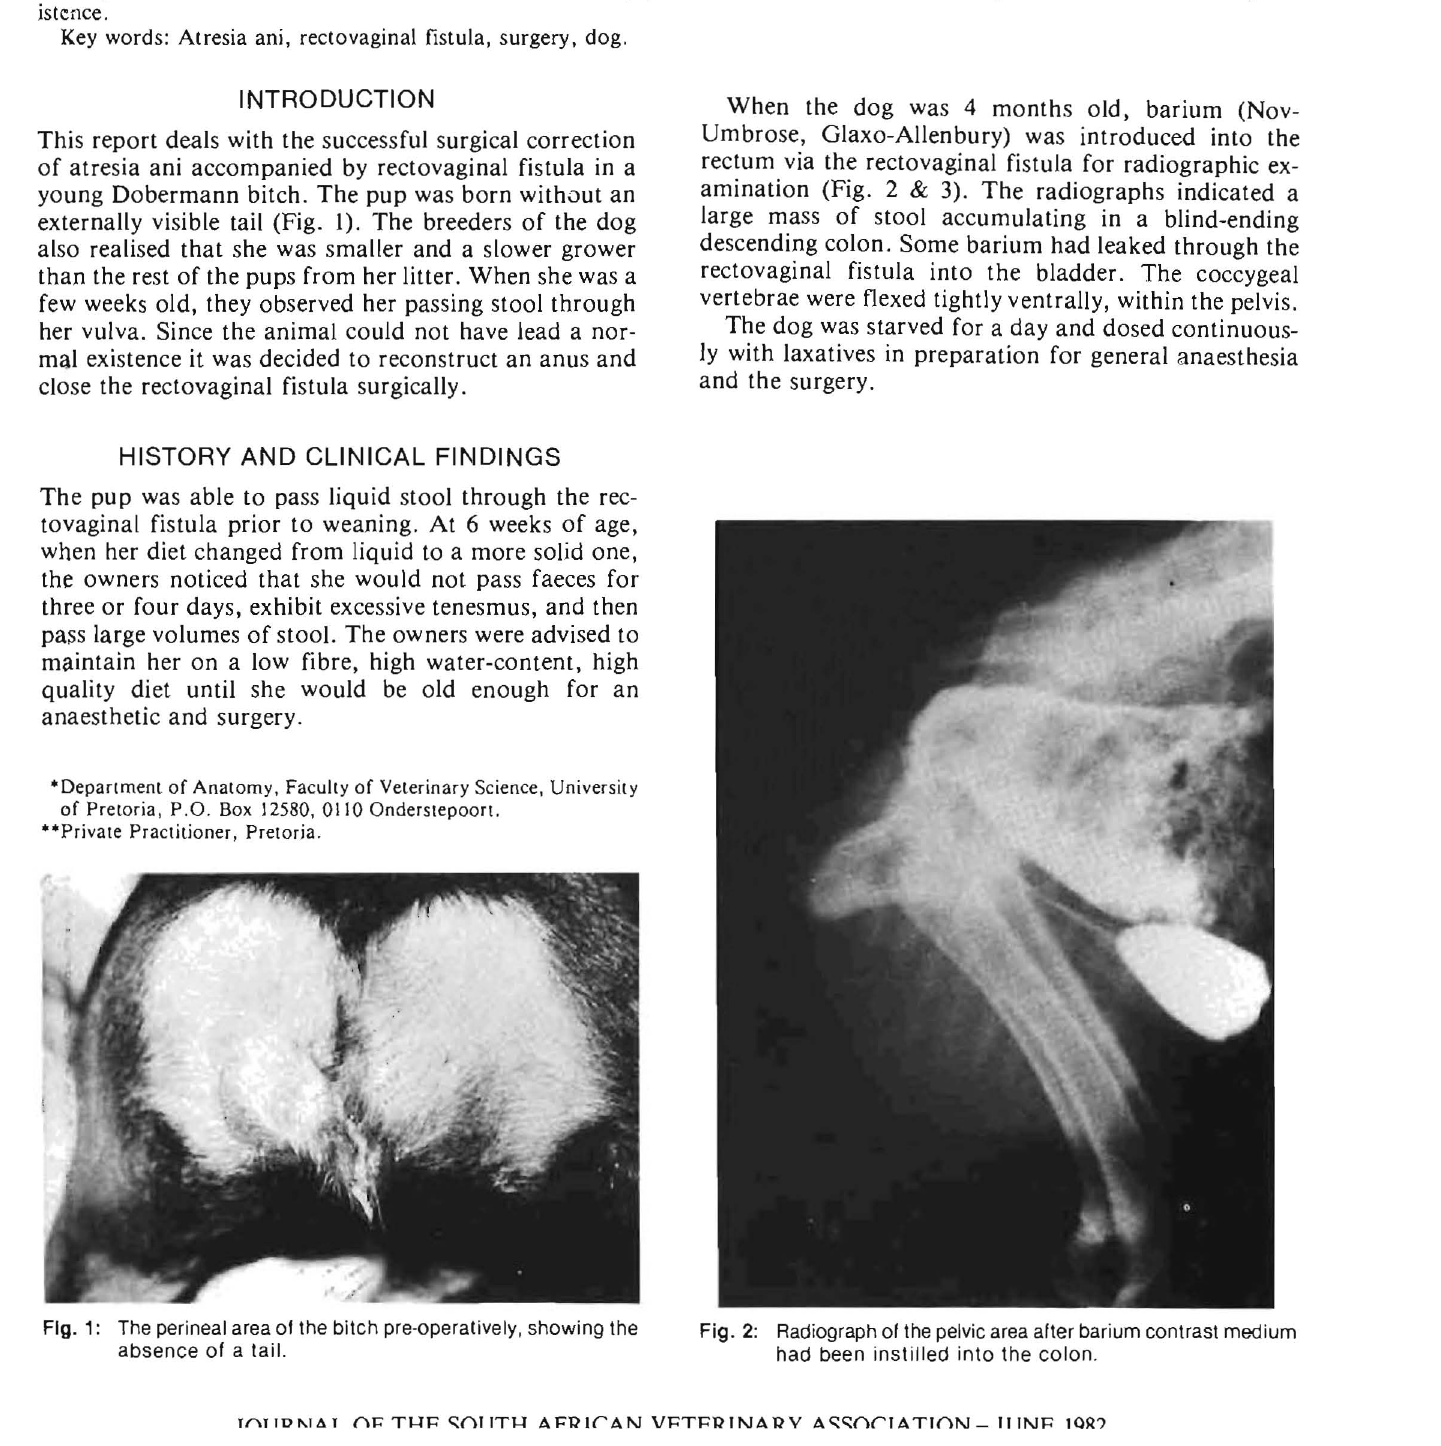
Fig. 2: Radiograph o/the pelvic area alter barium contrast medium had been instilled into the